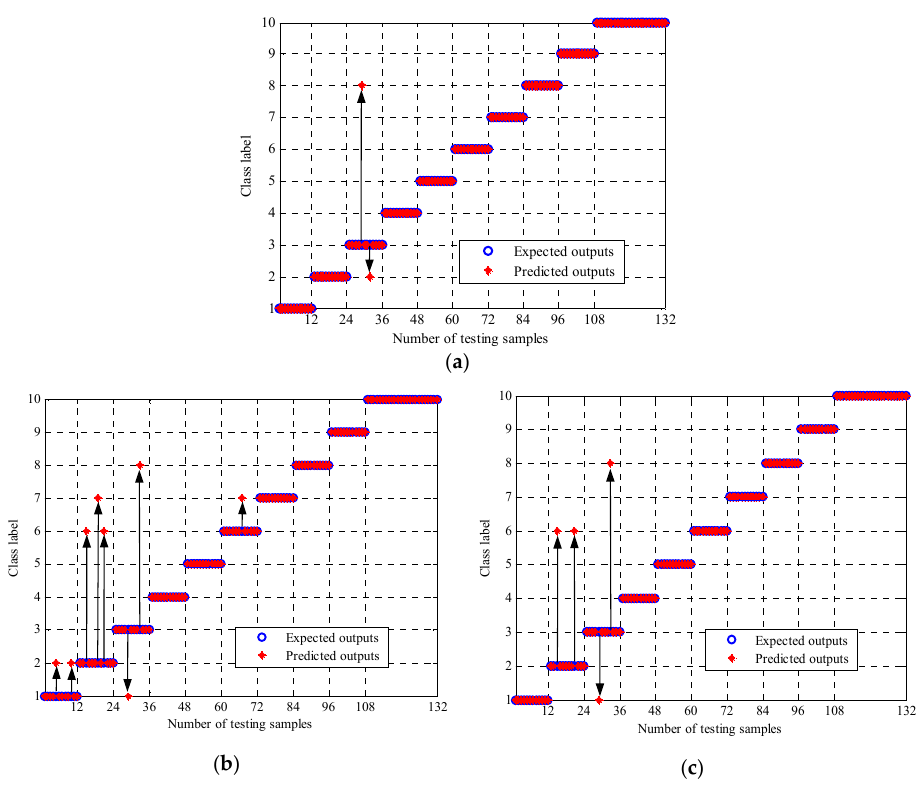
Figure 11. Misclassified testing samples by the classifier: ( a ) support vector machine (SVM), ( b ) neural network (NN), and ( c ) k-Nearest Neighbor (kNN).